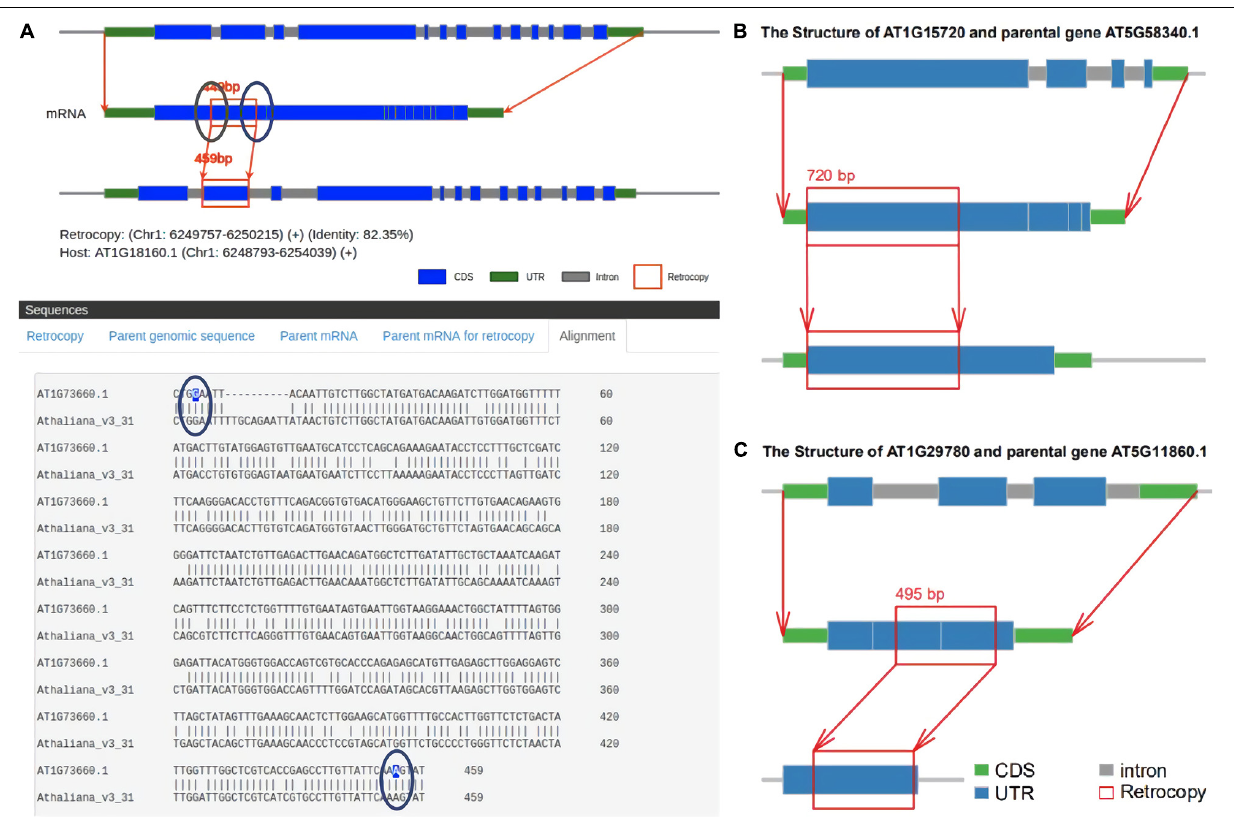
Frontiers in Genetics |